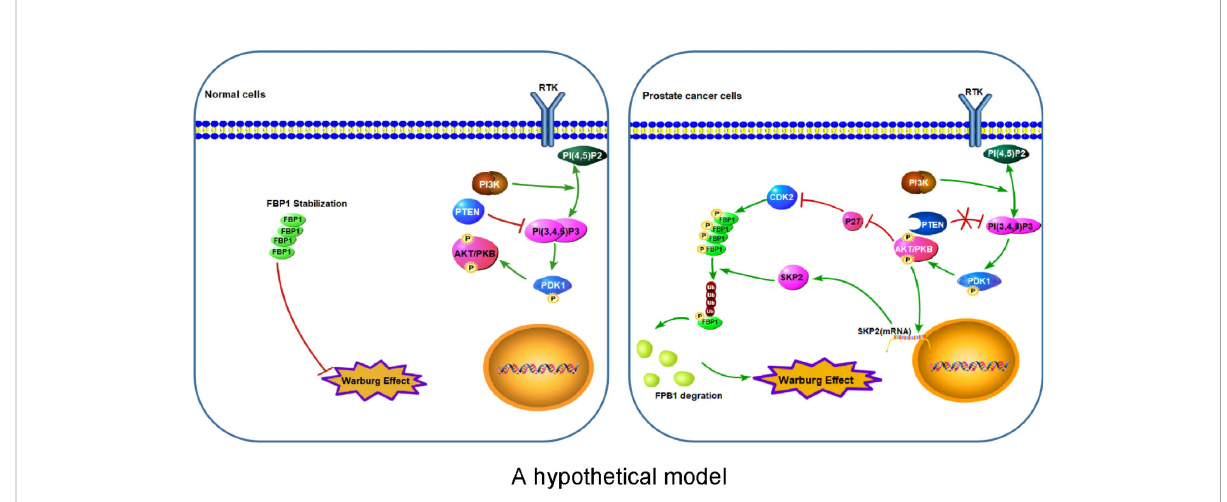
FIGURE 7 A hypothetical model Left: Stabilization of FBP1 protein prevents over-activation of the Warburg effect in normal cells. Right: Aberrant activation of the PI3K/AKT pathway due to deregulation of signaling such as loss of PTEN leads to CDK-dependent phosphorylation and ubiquitination and degradation of FBP1 mediated by SKP2 E3 ubiquitin ligase, thereby leading to abnormal activation of the Warburg effect and cell growth of cancer such as PCa. P letter with circle represents protein